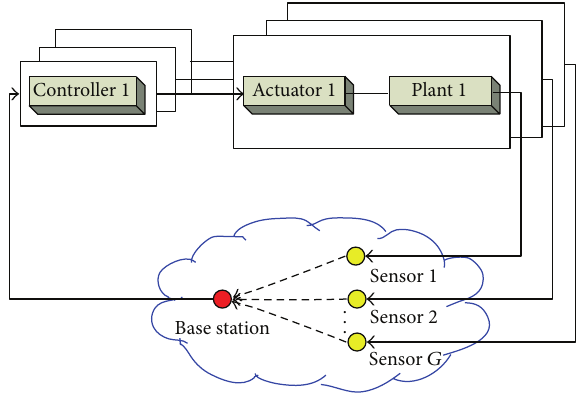
Figure 2: Star topology wireless sensor